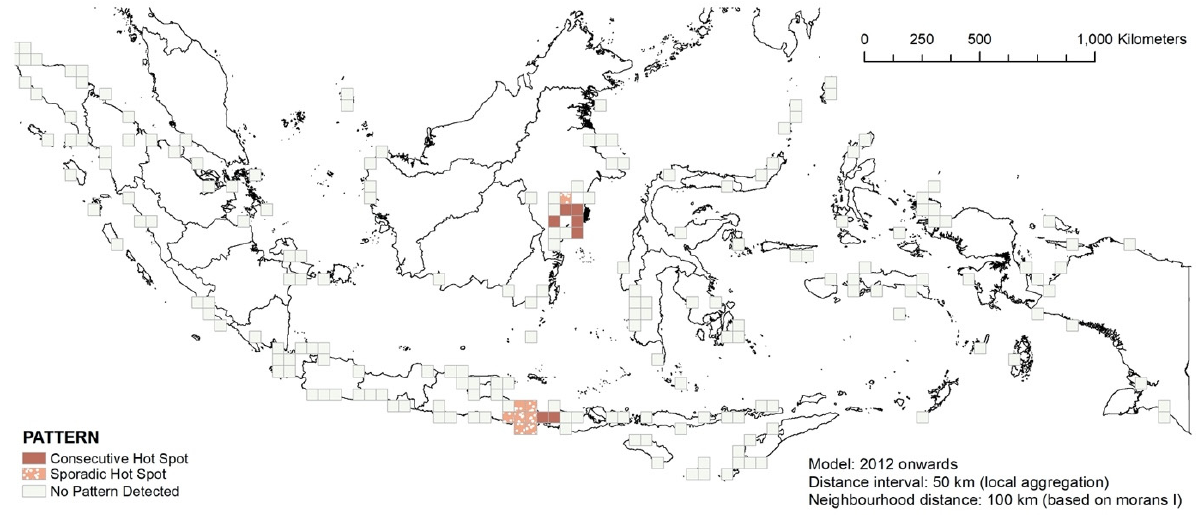
Figure 11. The space–time hotspot patterns of the 2012–2021 stranding events. Between 1995 and 2011, many places in Java, Nusa Tenggara and the southern part of Sulawesi experienced a 90–95% increase in stranding events, while Bali, East Java and Raja Ampat in West Papua experienced the highest increase in stranding events (99%, Supplementary Material Figure S5). The northern tip of North Sulawesi was the only place experiencing a downward trend in this period (Supplementary Material Figure S5). For the latter period, while some places in Sumatra and Java experienced a downward trend,